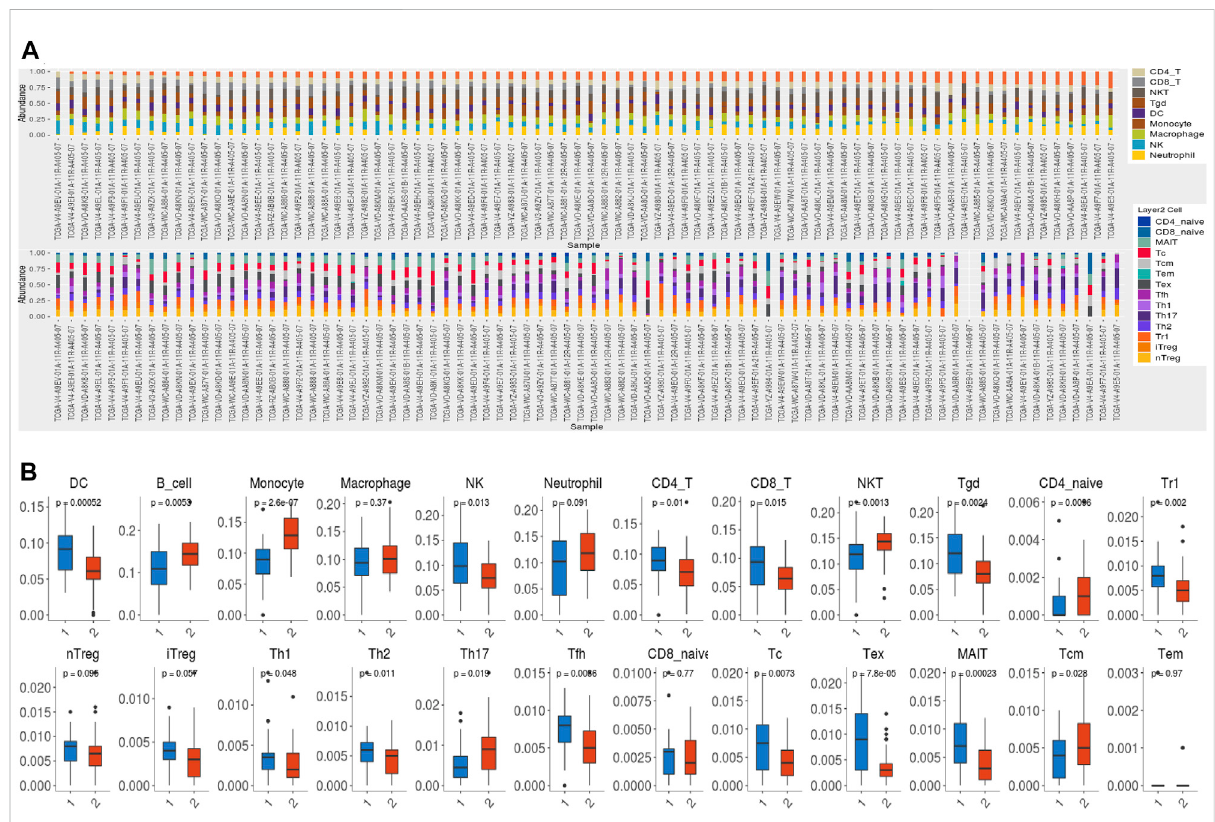
FIGURE 7 Immune in fi ltration. (A) TCGA cohortsamples of80UVMsamples contained 24immunecell types. (B) The differenceinimmunecellin fi ltration between the high- and low-risk groups. DC: dendritic cells; NK: natural killer cells; NKT: natural killer T cell; Tgd: γδ T cells; Tr1: type 1 regulatory T cells; nTreg: natural regulatory T cells; iTreg: induced regulatory T cells; Th1: T helper cell type 1; Th2: T helper cell type 2; Th17: T helper cell type 17; Tfh: follicular helper T cells; Tc: cytotoxic T cells; Tex: exhausted T cells; MAIT: mucosal associated invariant T cells; Tcm: central memory T cells; Tem: effector memory T